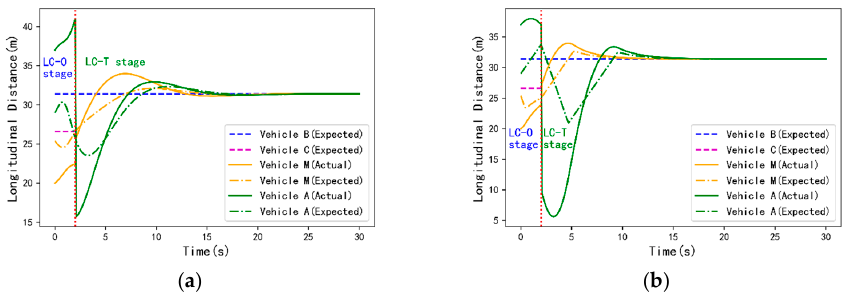
Figure 8. The actual and expected longitudinal distances between vehicles M, A and their preceding vehicles in two stages of the two control strategies in scenario 1. ( a ) The proposed CLC control strategy, ( b ) CACC_Sine control strategy.